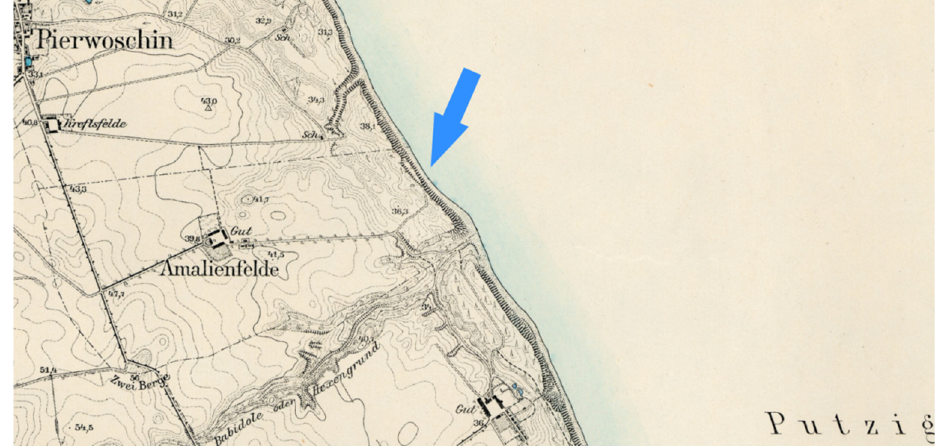
Figure 7. The analysed section of coastline on the map from 1908 (1:25,000). The blue arrow indicates the approximate location of KM 93.6–93.9.